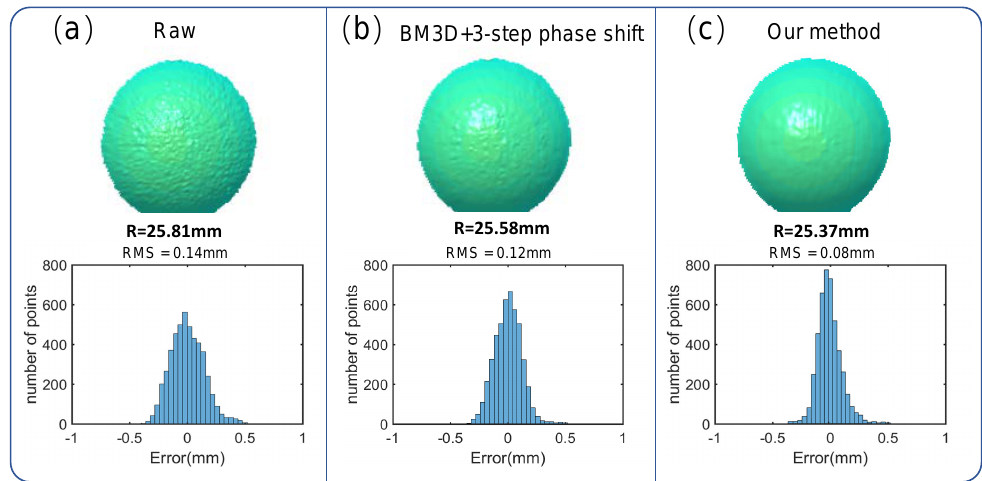
Figure 10. The 3D reconstructed sphere (top) and error pixels distribution (bottom) obtained by ( a ) direct three-step PS of the original IR fringes, ( b ) BM3D denoising with three-step PS, and ( c ) our